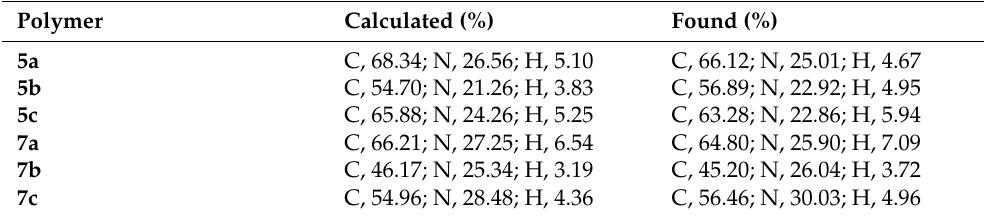
Figure 2. FT-IR spectrum of samples ( 7a – c ). Table 2. Calculated elemental analysis (%) and found (%) for 5a – c and 7a – c